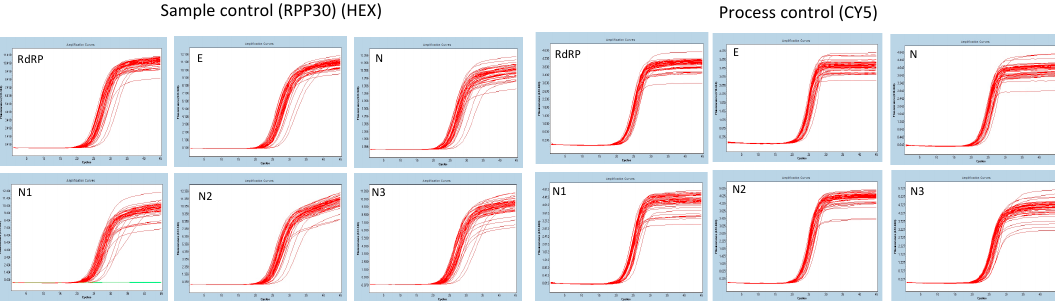
Figure 2. Figure depicting quality control targets. Left panel (sample control RPP30) and right panel—(process control AEC)— n = 60, 30 collected with Rayon swabs and 30 collected with cotton swabs. No difference was observed between both Rayon and cotton.